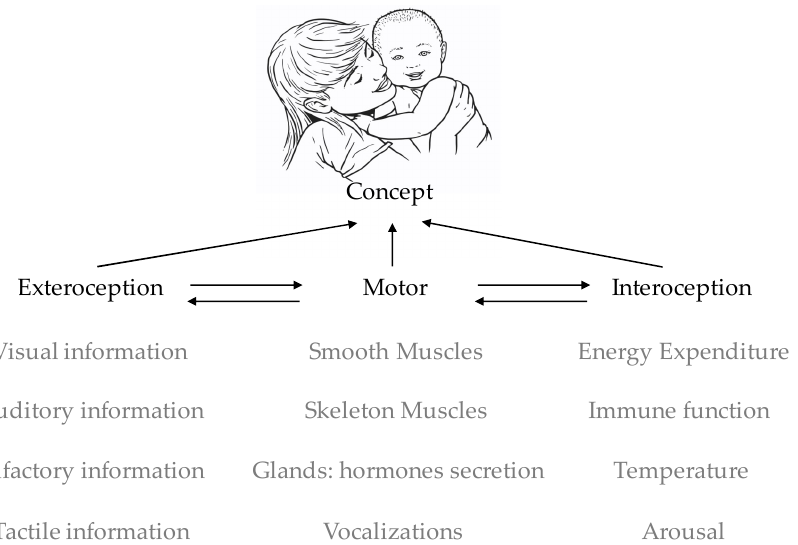
Figure 2. Basic ingredients of learning favor social development. During development, infants organize sensory-motor information into concepts. Information includes the exteroceptive perception of the environment, interoceptive perception of the body, execution of motor control over behavior (skeleton muscles), and visceromotor control of the internal milieu via the autonomic and endocrine systems (contraction of smooth muscles, hormonal secretion from glands). Two domain-general processes that impact learning are statistical learning of the environment [109–111] and motivated learning guided by allostatic demands [93]. In social animals, the environment is primarily social, and allostasis is regulated primarily via social interactions. Therefore, the first and most prominent learning humans do is social. Accordingly, a deficiency in multi-modal integration of the basic ingredients that determine the ability to learn concepts, including perception, motor control, and allostasis regulation, results in atypical social development.